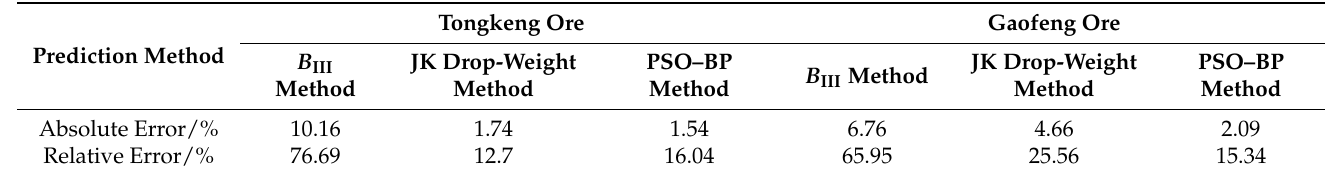
Table 11. Error comparison of different